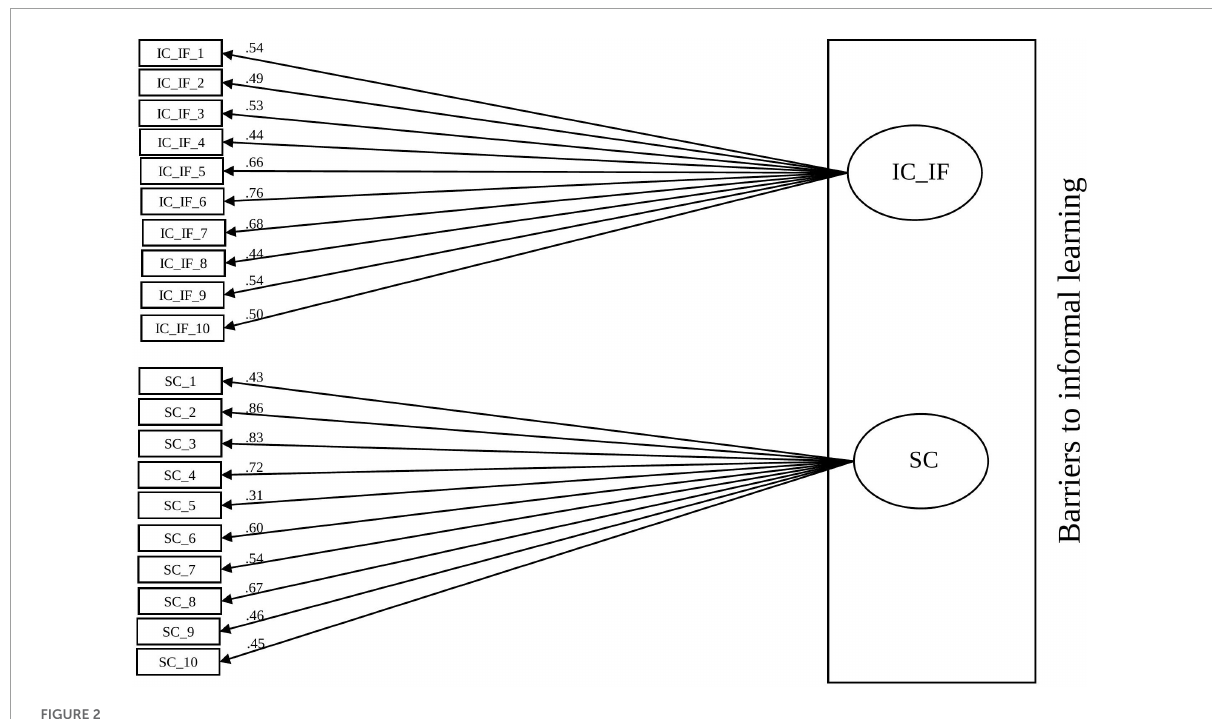
FIGURE2 Measurement model of barriers to informal